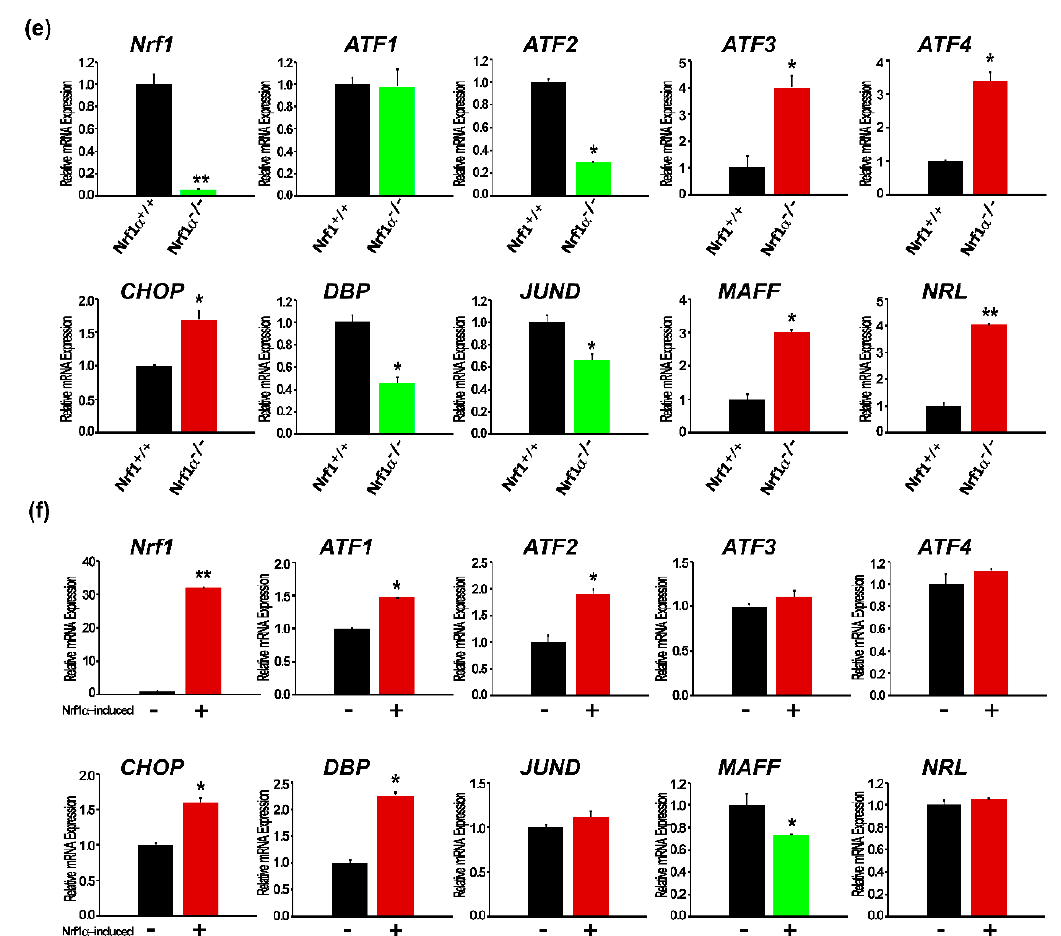
Figure 4. Classification of human bZIP factors within their interaction networks converged on a hub of Nrf1 α . ( a ) The phylogenetic tree of 53 bZIP proteins in humans was constructed by the same method as described in Figure 2. ( b , c ) Distinct or opposing changes in some nodes within the two interaction networks, which are composed of all human bZIP proteins and also converged on a hub of Nrf1 α , were determined following knockout of Nrf1 α ( b ) or induction of this protein expression by tetracycline treatment of HEK293C Nrf1 α cells ( c ). Significant up-regulation (Log2-based RPKM value >1) of the indicated genes were red-labeled, whereas down-regulation (Log2-based RPKM value < − 1) of other indicated genes were green-labeled. Of note, such a green-to-red gradient of those coding genes demonstrates from being down- to up-regulated. Additional genes without any detectable signals by transcriptome sequencing were also blue-labeled. ( d ) A heat map was made by the Log2-based RPKM values, representing differential expression profiles of human bZIP proteins in Nrf1 α − / − or HEK293C Nrf1 α (when compared with wild-type Nrf1 +/+ HepG2 or un-stimulated HEK293C cells, respectively). Different changes in the expression of some genes were shown to distinct degrees of colors. ( e , f ) Relative expression levels of selected bZIP genes were also validated by qRT-PCR analyses of Nrf1 α − / − vs. Nrf1 +/+ ( e ), or the stable tetracycline-inducible HEK293C Nrf1 α vs. un-stimulated cells ( f ). Subsequently, significant decreases or increases (* p < 0.05, ** p < 0.01) in the expression of some genes were determined. The black histograms indicate the basal Nrf α expression ( e ) or its background control levels with no induction ( f ) . The red and green histograms show increases and decreases upon knockout of Nrf α ( e ) or its inducible expression ( f) , respectively .